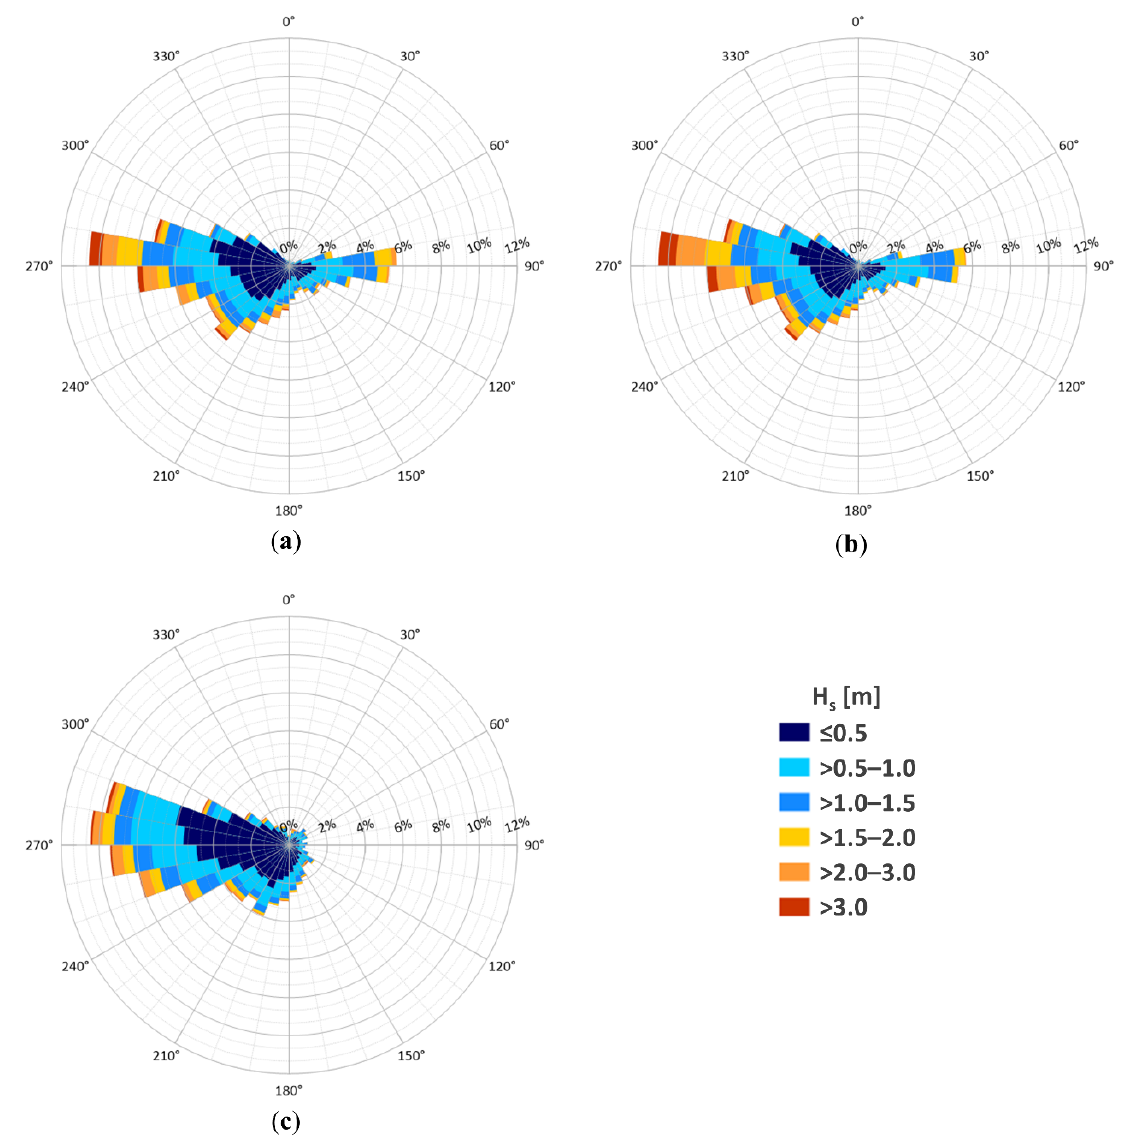
Figure 2. Wave climate referenced to different wave height classes (in legend): ( a ) at Ponza buoy; ( b ) at point O, as obtained by transposition of Ponza wave buoy data; ( c ) at ECMWF point E3.